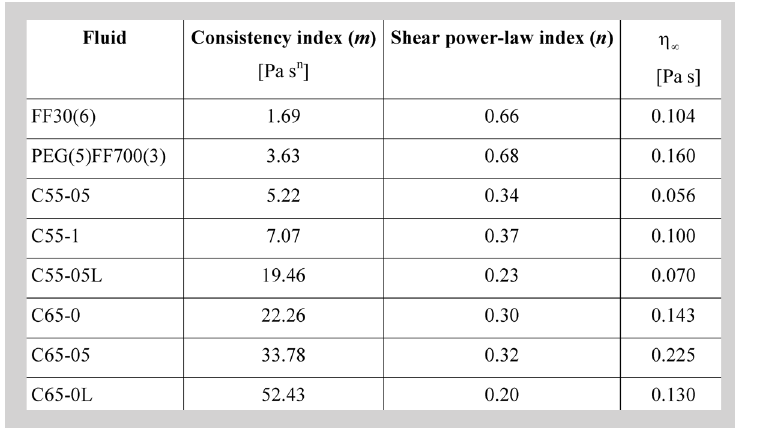
Table 2: Power-law parameters of all the